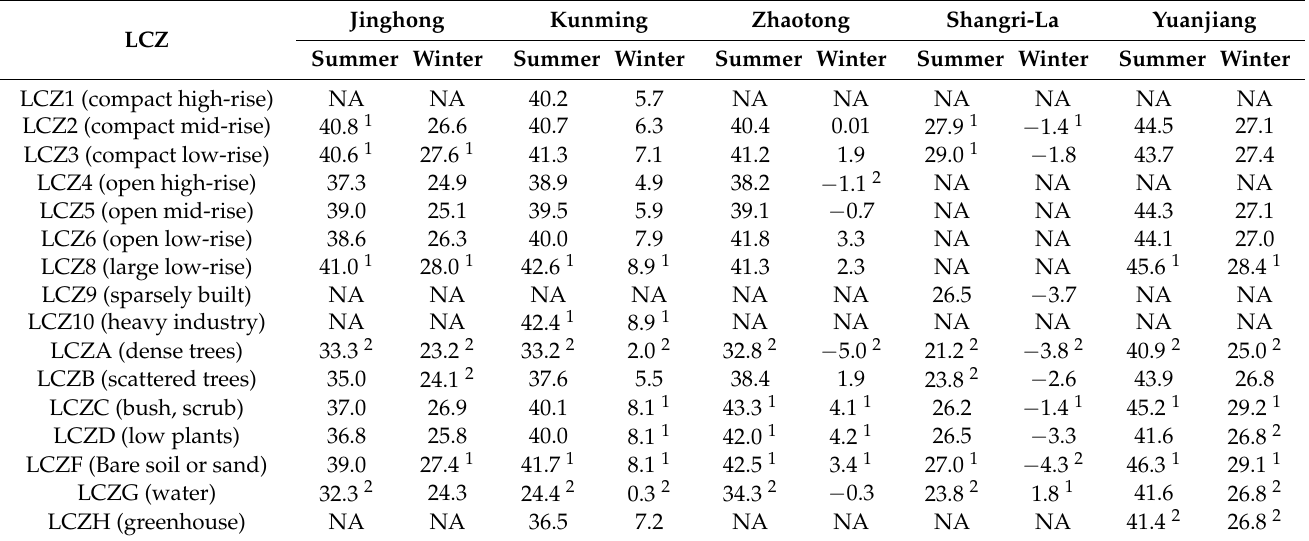
Table 2. Mean LST per LCZ in winter and summer (NA represents no-data value, unit: ◦ C).